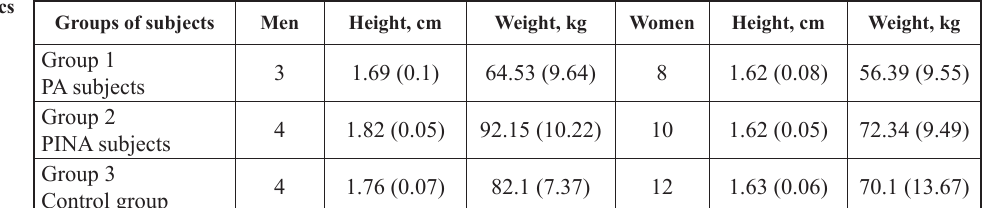
Figure 1. The protocol of the research